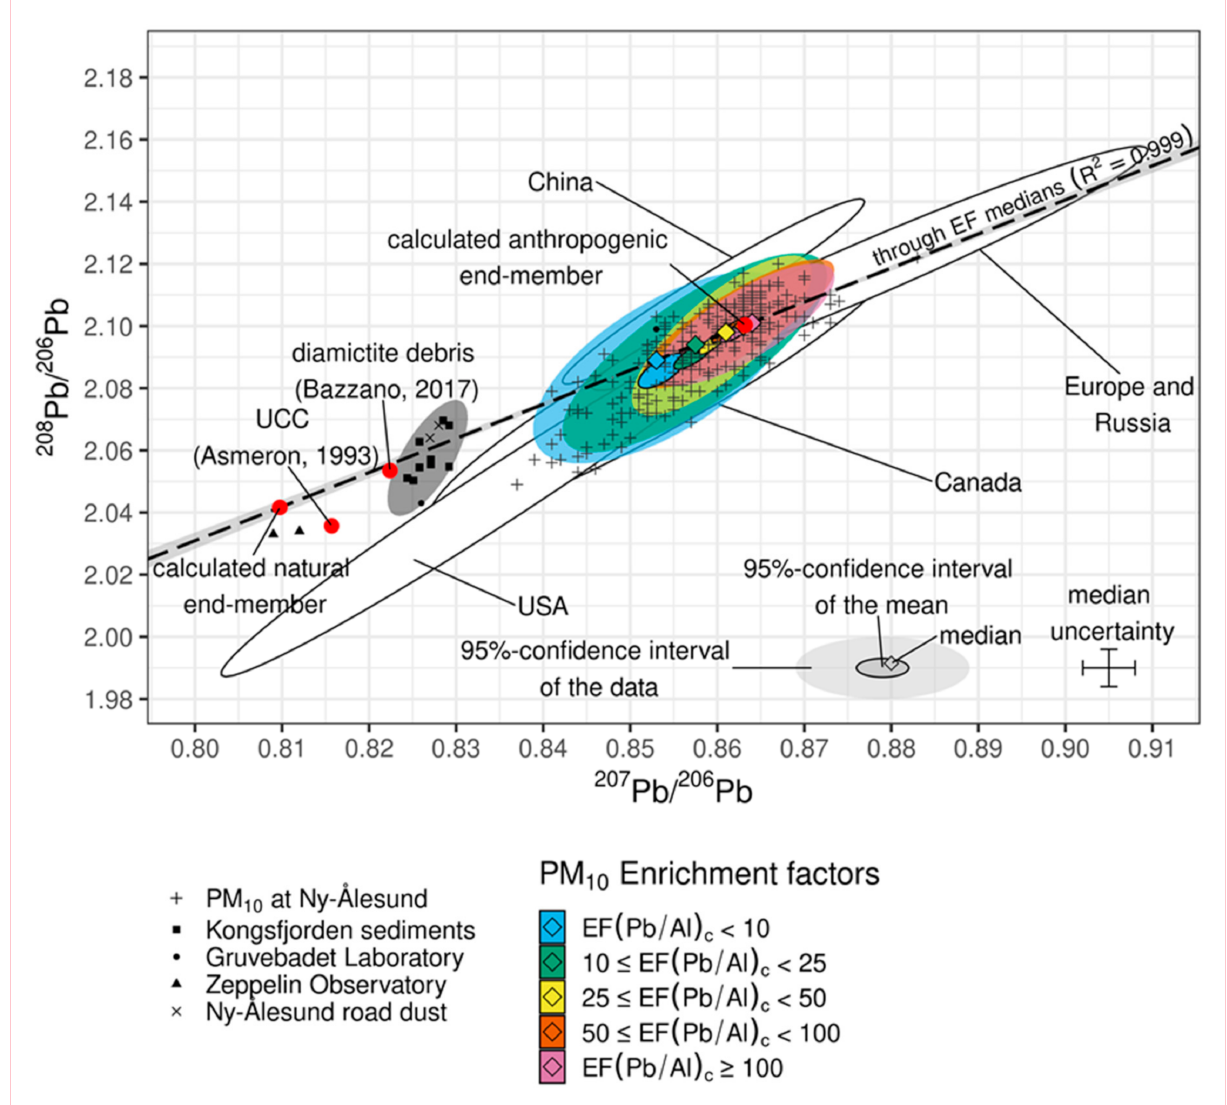
Figure 1. Three-isotope plot for Pb isotope ratio values measured in PM 10 samples collected at Ny-Ålesund from 2010 to 2018. Ellipses represent the joint-distribution (95% confidence level) of literature data. Canada and USA: [22,38], Europe: [21,22,39] Russia: [21,22], China: [22,40]. Pb isotope ratio values for crustal samples from: Kongsfjorden sediments and diamictite debris [36,41,42], UCC [35], Gruvebadet Laboratory, Zeppelin Observatory and Ny-Ålesund road dust are unpublished data from the research group of the University of